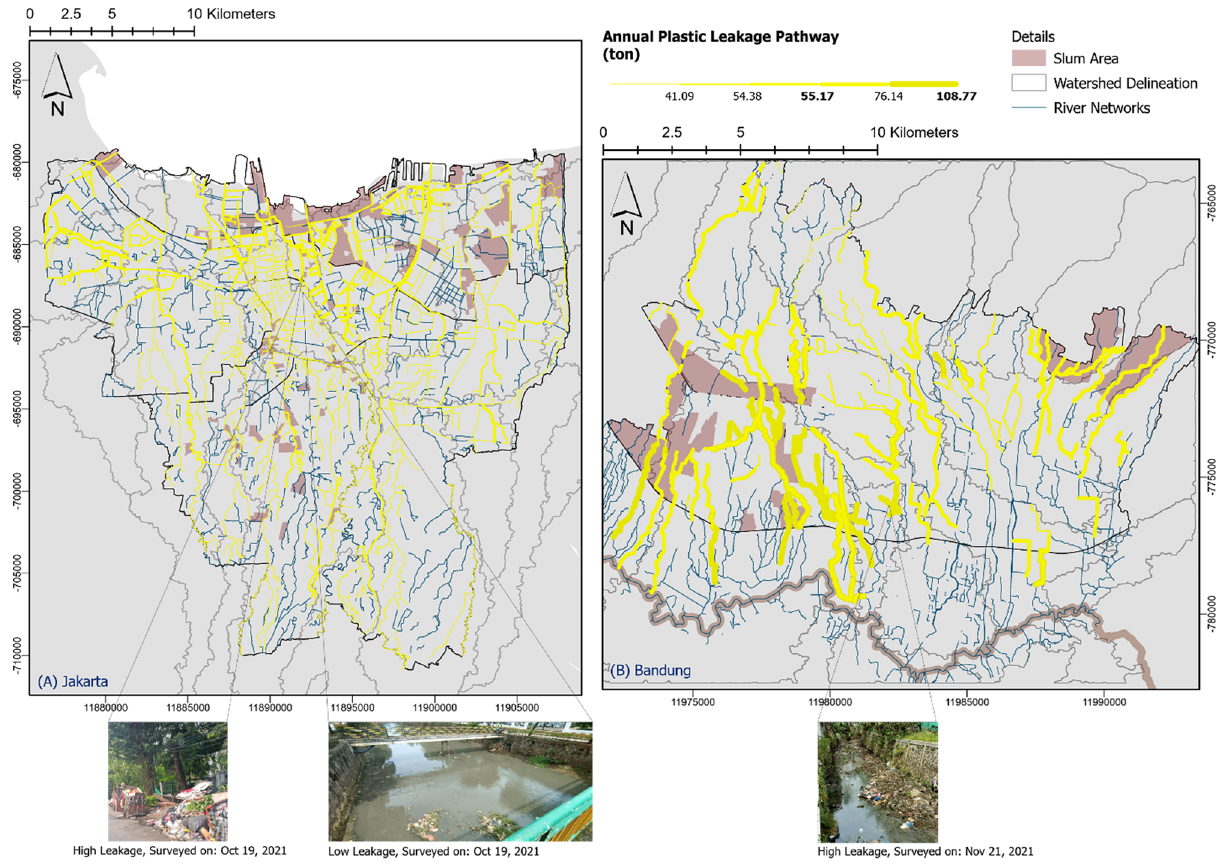
Figure 4. Plastic leakage pathway model in DKI Jakarta and Bandung City based on the accumulation input to the